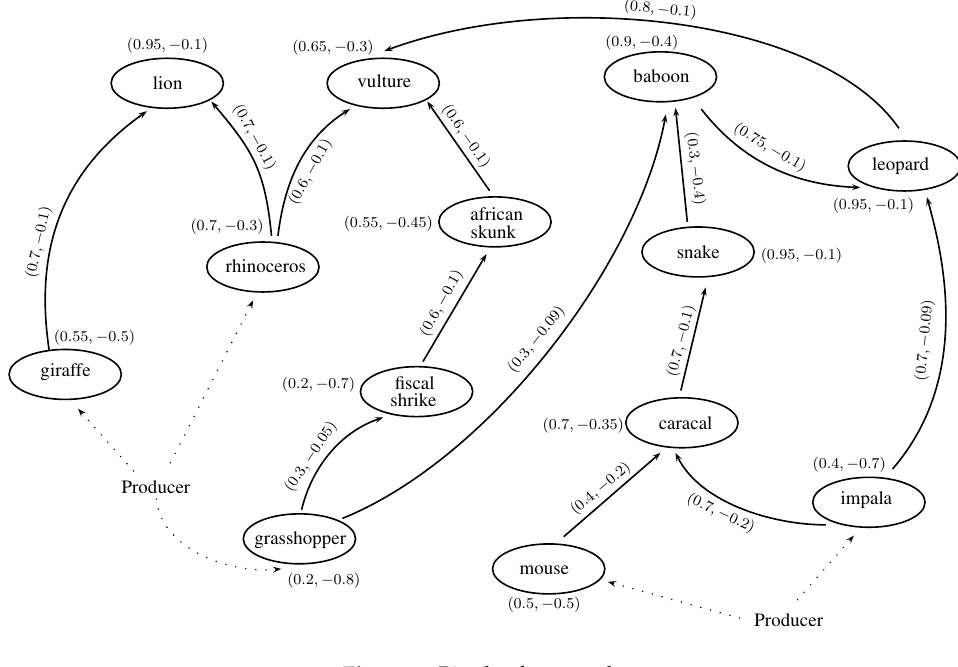
Figure 2.3: Bipolar fuzzy web Figure 3. Bipolar fuzzy web.